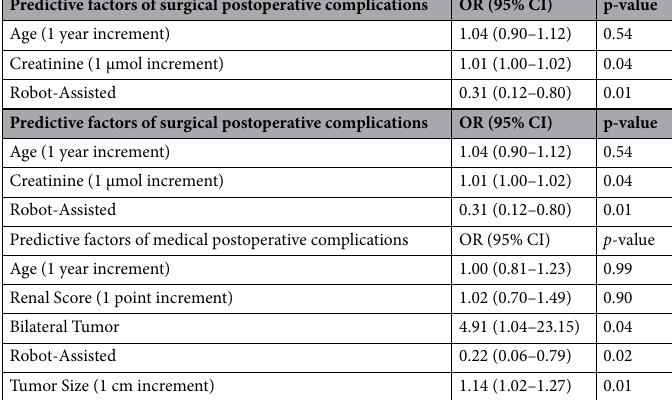
Table 4. Multivariate Logistic Regression of predictive factors of